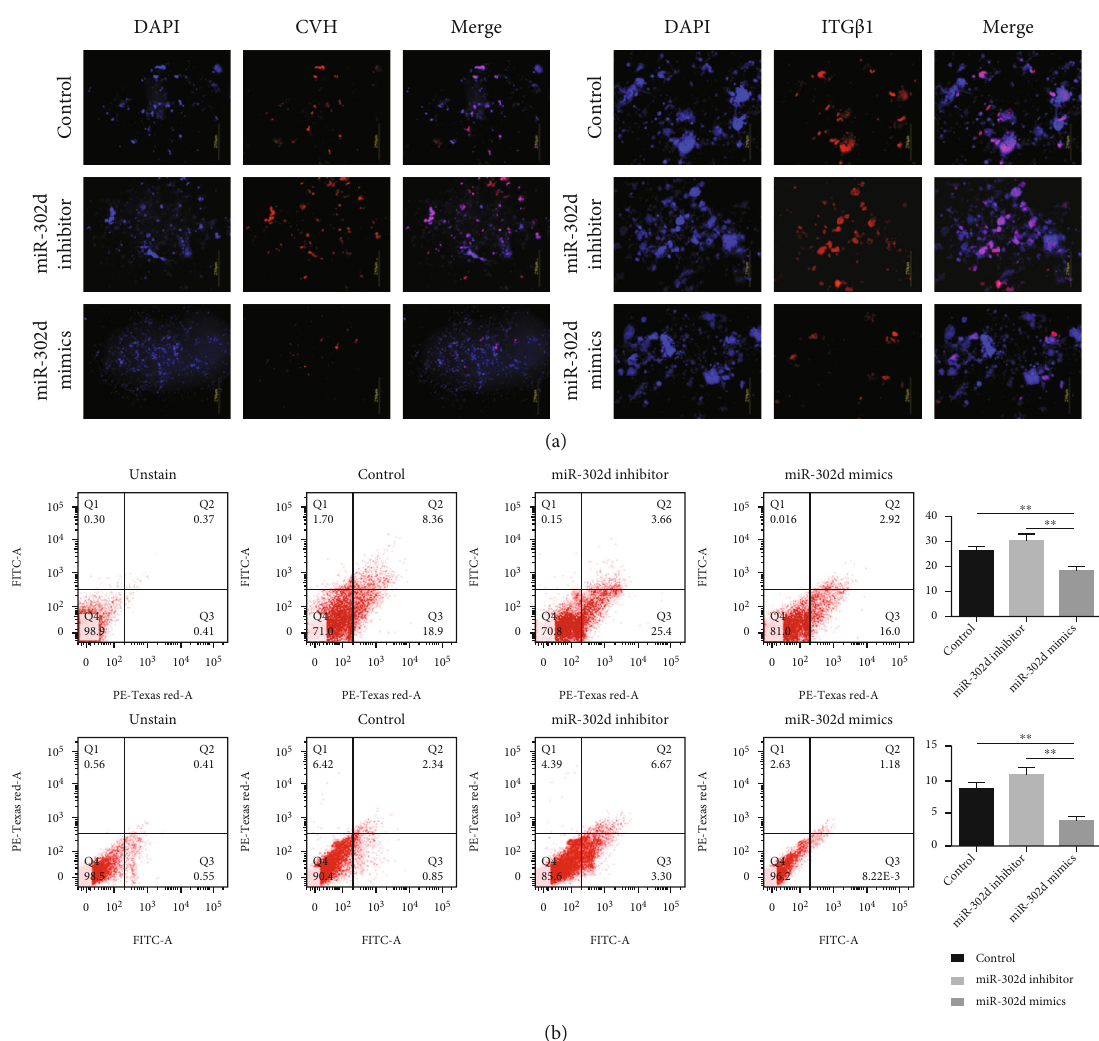
Figure 3: miR-302d function veri fi cation in vitro. (a) Immuno fl uorescence test on day 4 and day 10. (b) Flow cytometry analysis on day 4 and day 10, and quanti fi cation of positive cells; here, PE-Texas Red means TRITC